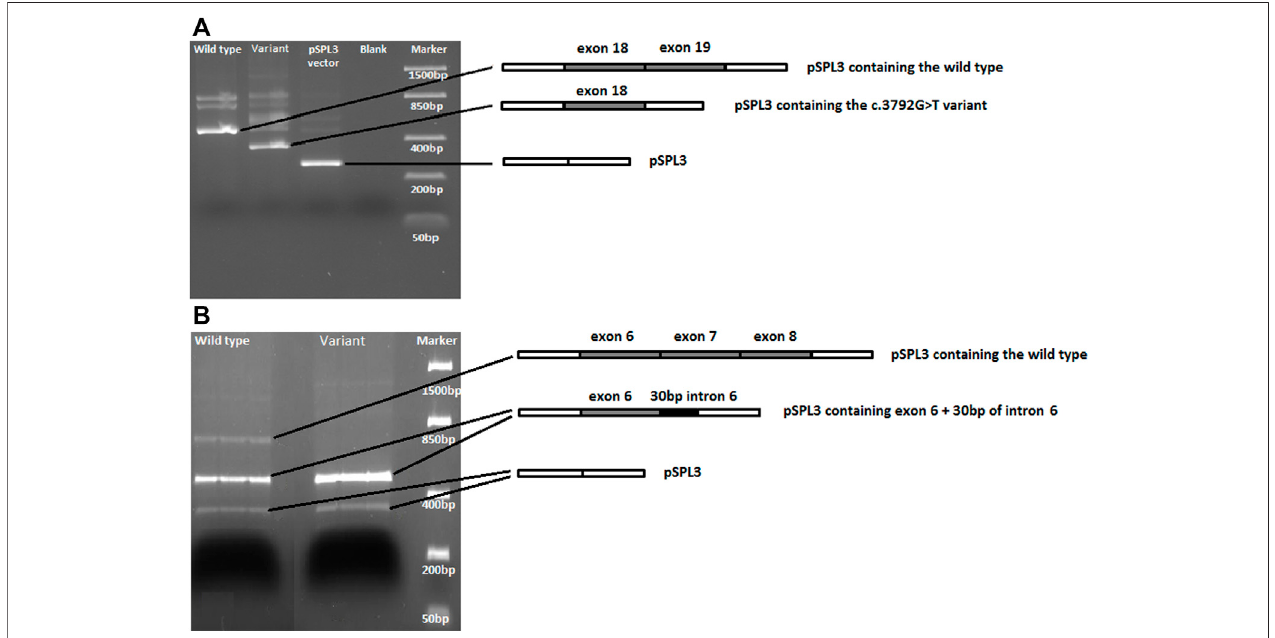
FIGURE 4 | DNA gel electrophoresis of PCR-ampli fi ed cDNA fragments generated from wild type and variant sequences. (A) For the CACNA1G c.3792G > T variant, the variant fragment is shorter and lacks exon 19 compared to the wild type fragment. (B) For NOP56 , both the wild type and the c.909G > A variant sequences produce a fragment carrying exon 6 and 30bp of intron 6. However, the c.909G > A variant PCR product lacks the expected cDNA fragment carrying exons 6, 7 and